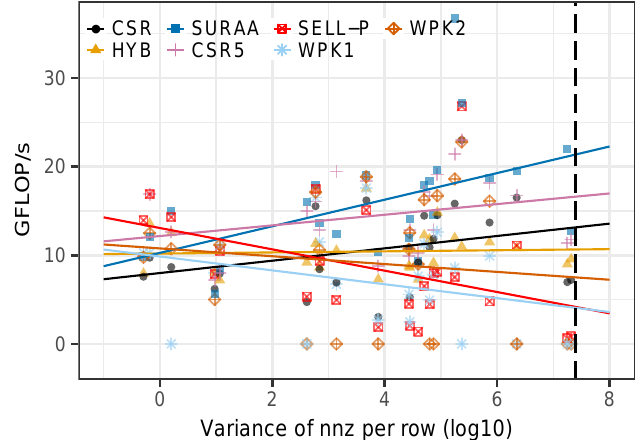
Figure 10. Throughput against npr variance for the benchmark suite comprising 26 matrices (compared schemes: CSR5, WPK1, WPK2, HYB, SELL-P, CSR, and SURAA).